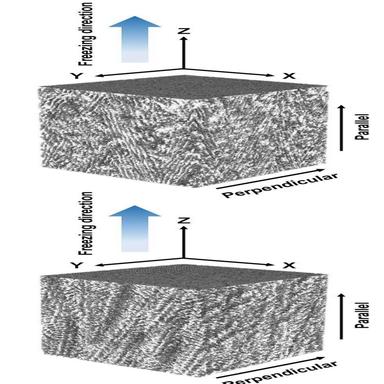
Three-dimensional images of Ni foam reconstructed from XCT scans with varying volume fraction of NiO powder in the slurry: (a) 5 vol% and (b) 7 vol%. The cube length is 1 mm. The z-axis direction is the freezing direction.